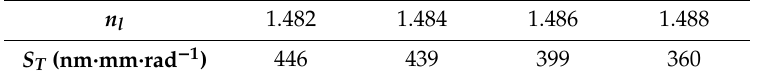
Table 3. Torsion sensitivities of several fiber sensors.